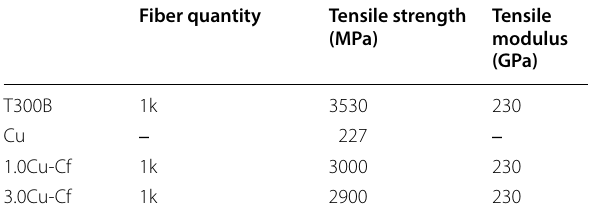
Table 1 The parameters of carbon fiber